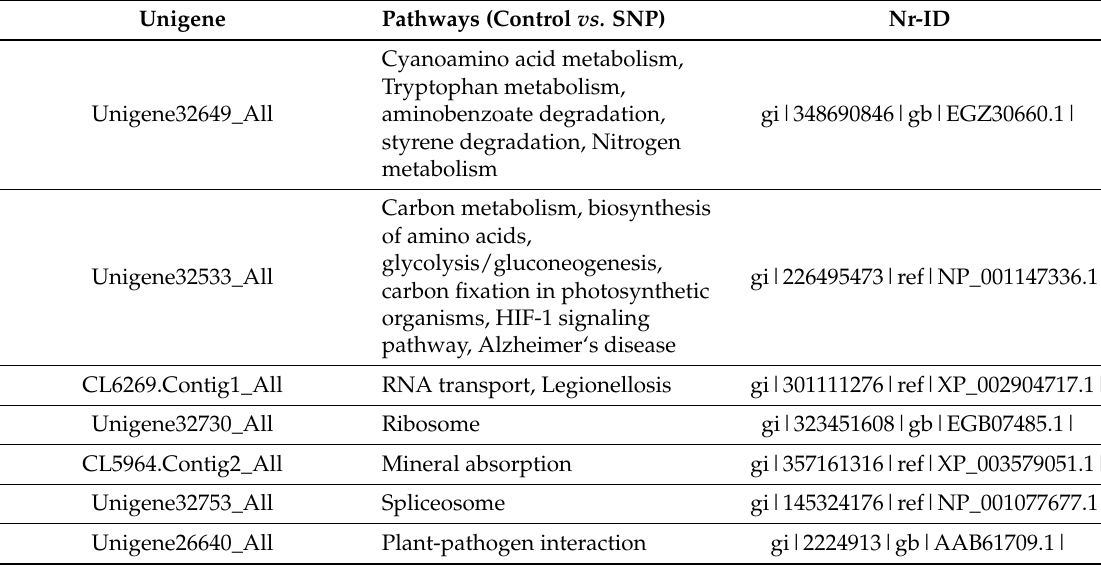
Table 1. Gene pathways enriched in the top 50 highly expressed genes.